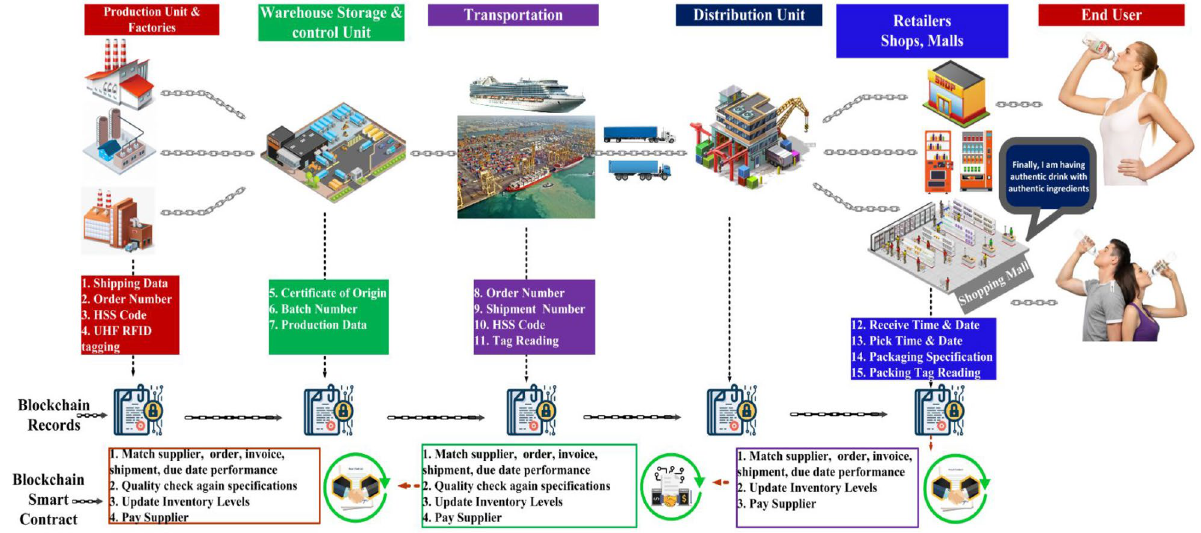
Figure 1. RFID and blockchain based framework for liquid bottle product traceability in the supply chain from manufacturer to retailer. Consumers and suppliers can trace and track the RFID tagged liquid bottle products using blockchain based